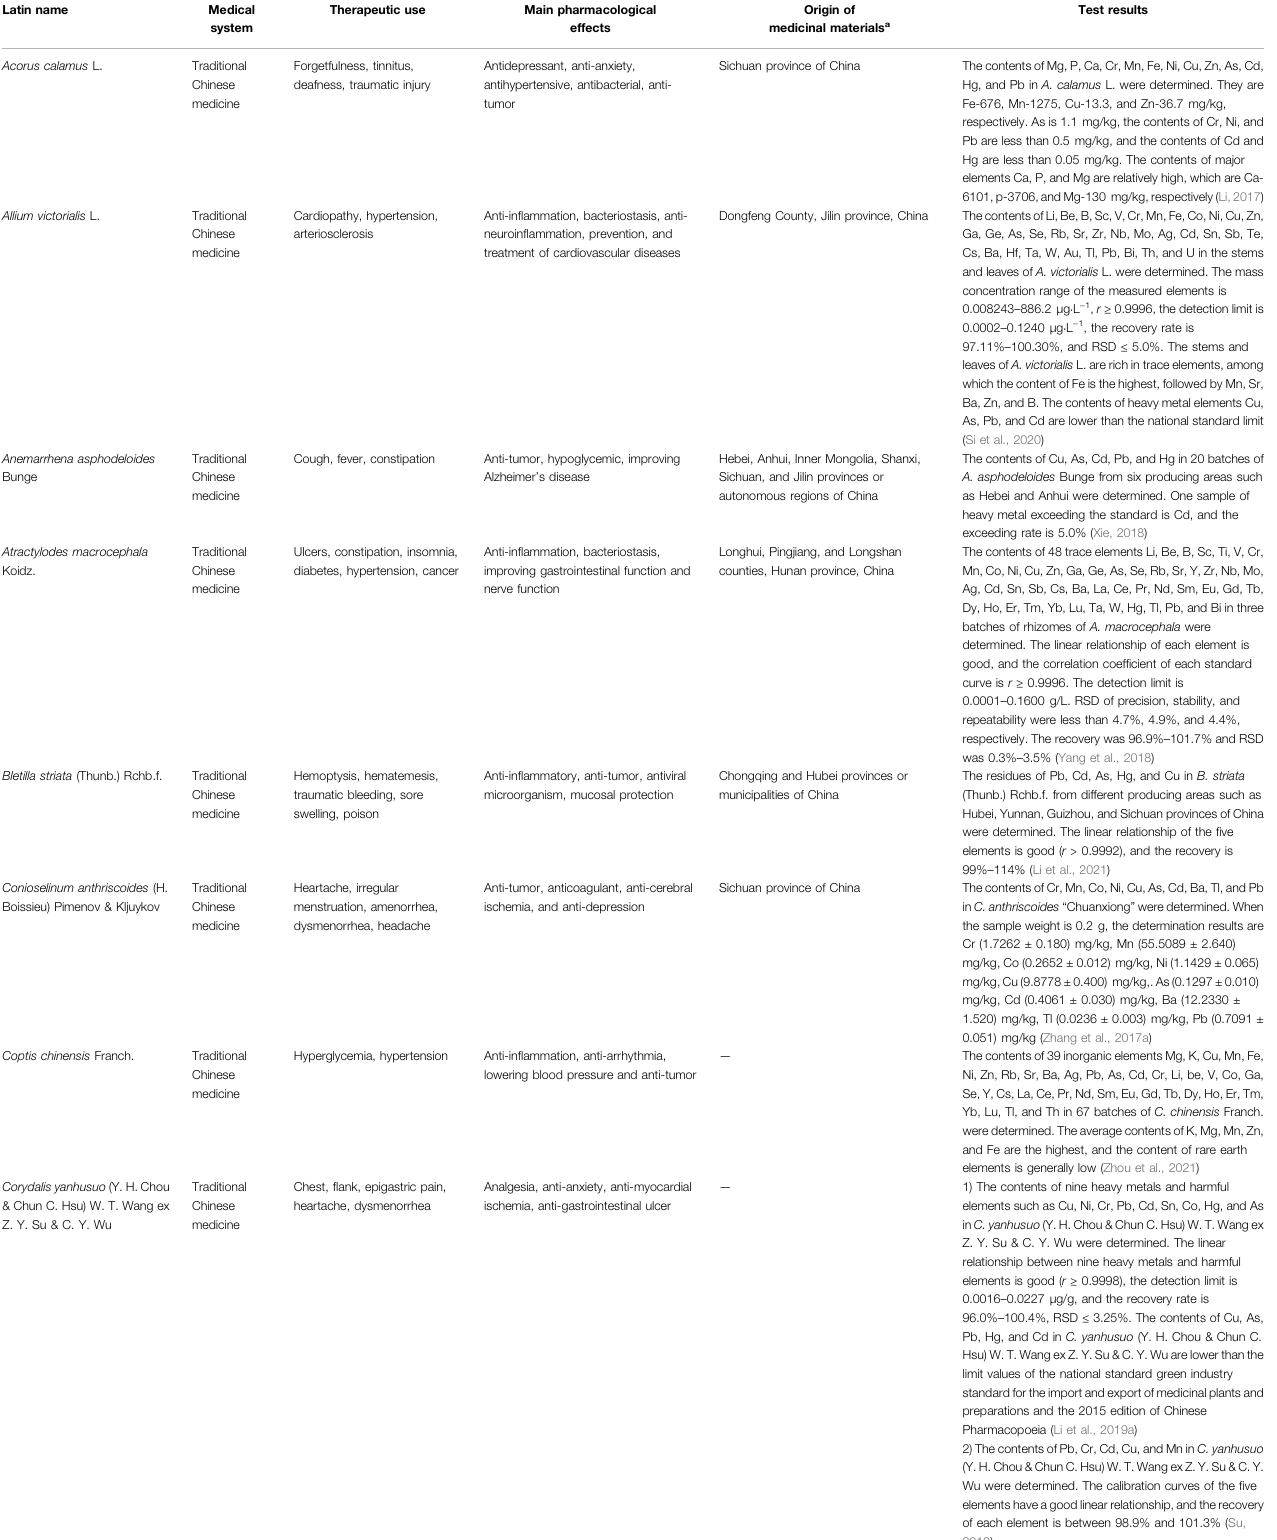
TABLE 2 | Application of ICP-MS in the determination of heavy metals in medicinal materials derived from the stem of